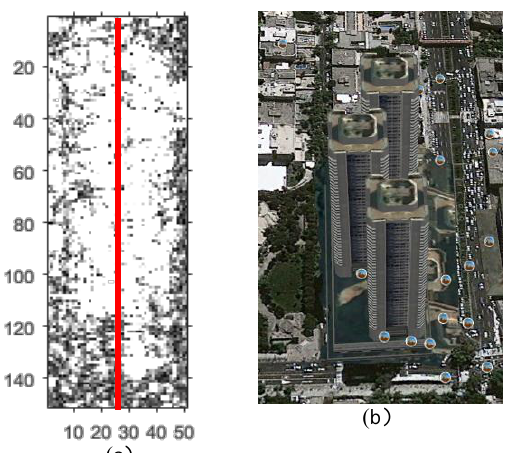
Figure 1 . Study area over Eskan towers. (a) The average amplitude of 19 SAR images. (b) The position of the towers.